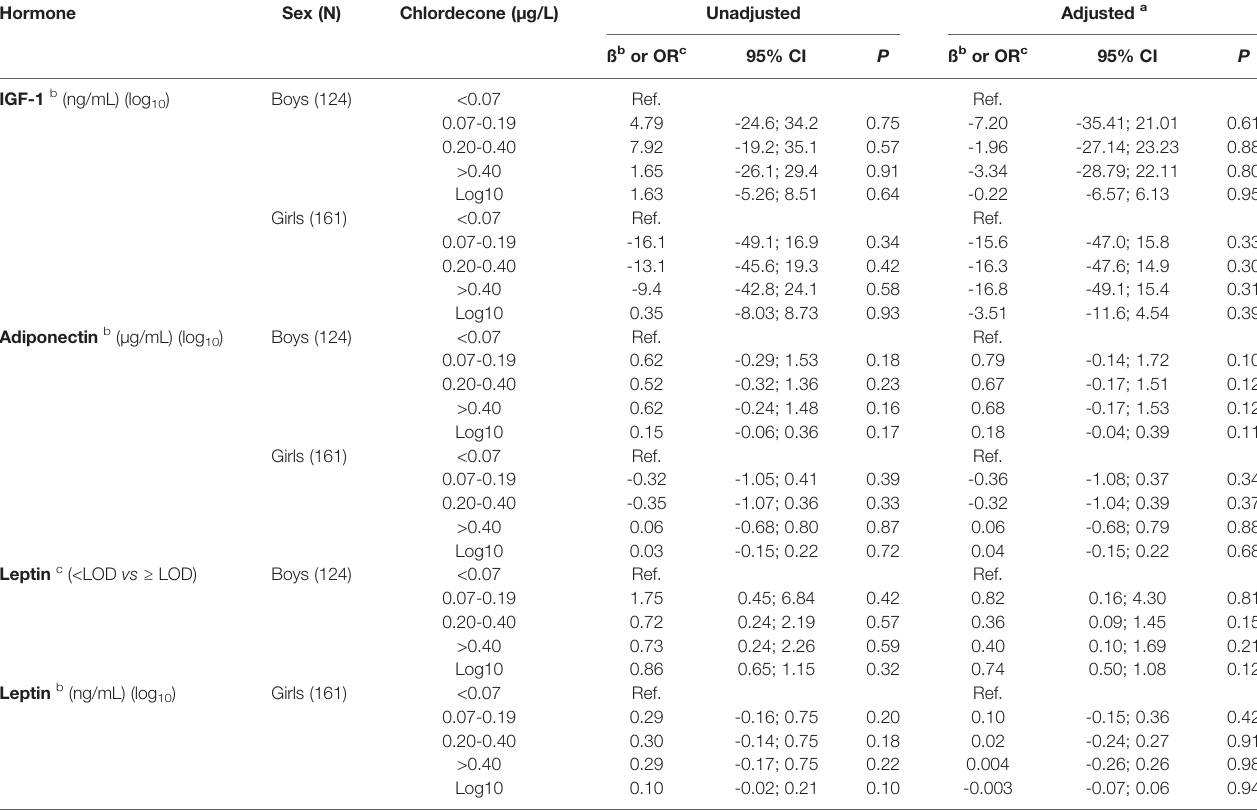
TABLE 5 | Associations between in utero (cord blood) chlordecone exposure and metabolic hormone concentrations at seven years of age in children of the TIMOUN cohort. Hormone Sex (N) Chlordecone (µg/L)